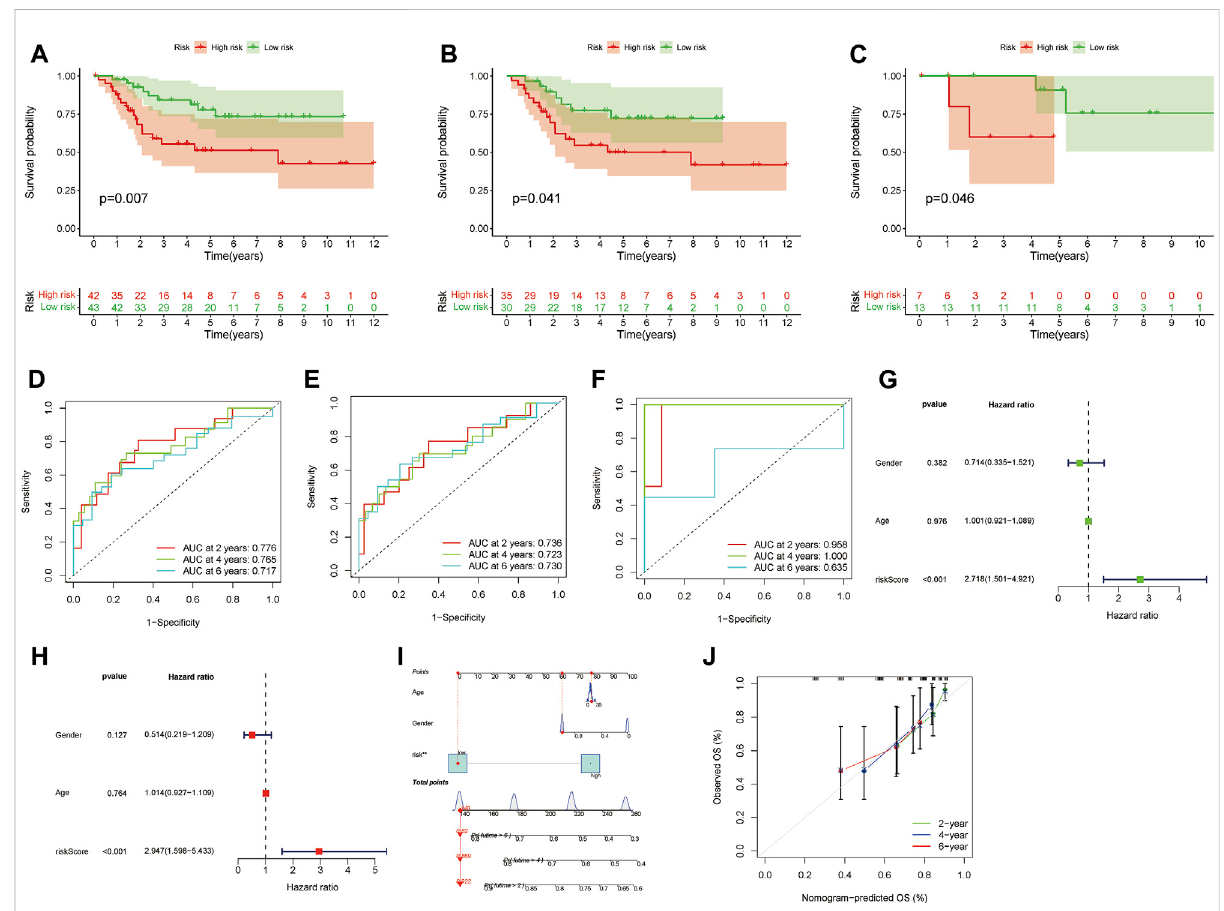
Evaluate the prognostic ability of the signature. (A – C) Kaplan – Meier survival estimates of overall survival of patients by the signature in the entire, train and cohorts, respectively. (D – F) The entire, train and cohorts of ROC curve analysis, respectively. (G,H) Univariate and multivariate analyses the signature. (I) A nomogram included clinical features and riskscore for predicting the overall survival of patients with OS at 2-, 4-, and 6- years. (J) Calibration curves for 2-, 4-, and 6-years forecasts of